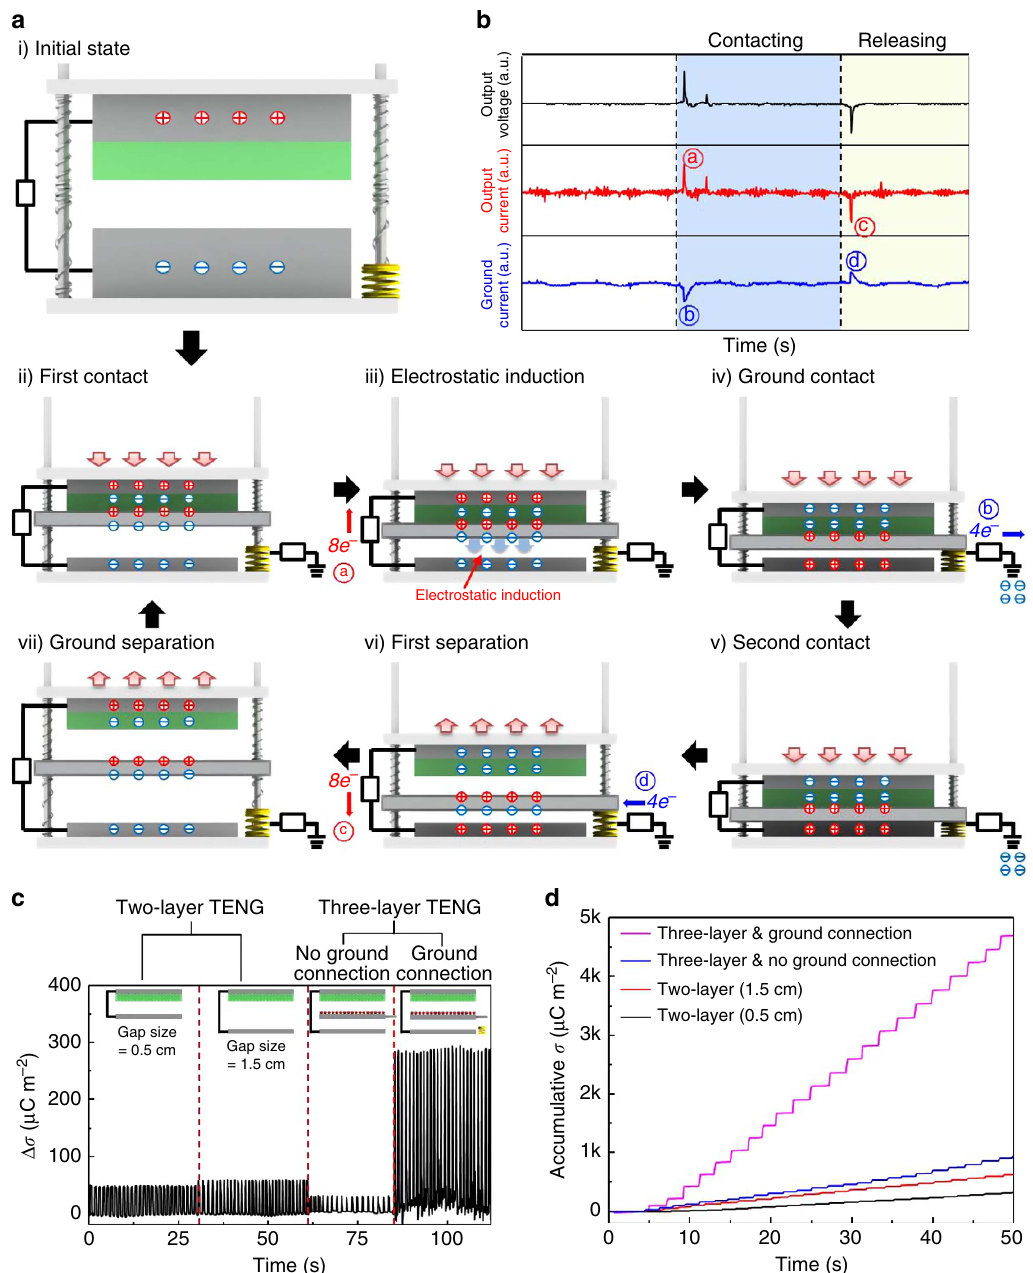
Figure 3 | Working mechanism of three-layer structured triboelectric nanogenerator. ( a ) Working mechanism for the generation of output voltage and current in the TENG under external force. ( b ) The output voltage and current produced by the TENG, and the current measured between the middle layer and ground. ( c ) The charge densities and ( d ) the accumulative charge densities at two-layer structured TENGs with gap sizes of 0.5 and 1.5cm, and three-layer structured TENGs with and without a ground